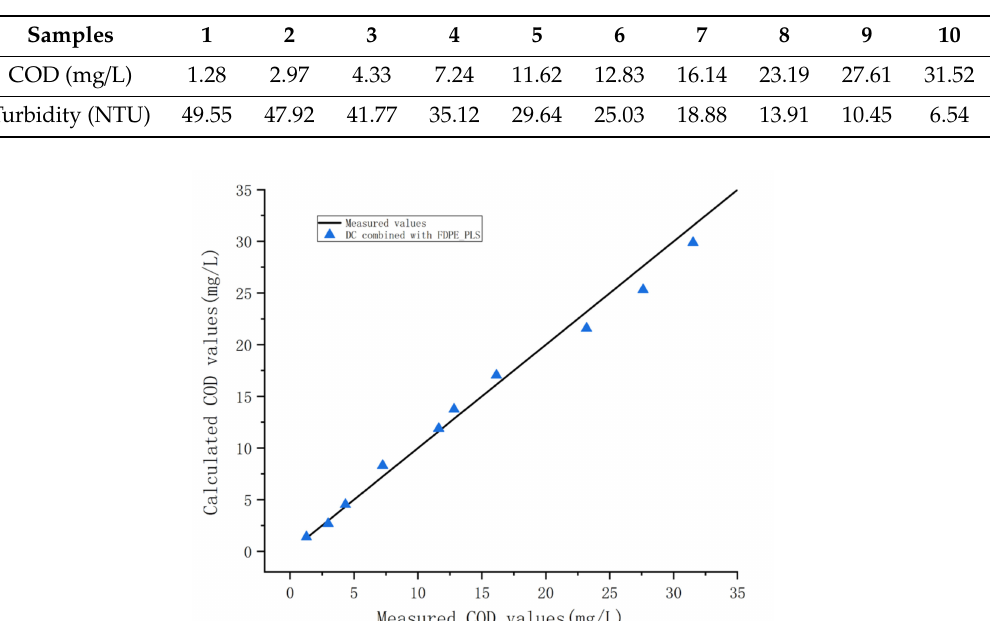
Table 10. The COD and turbidity values of ten actual samples.